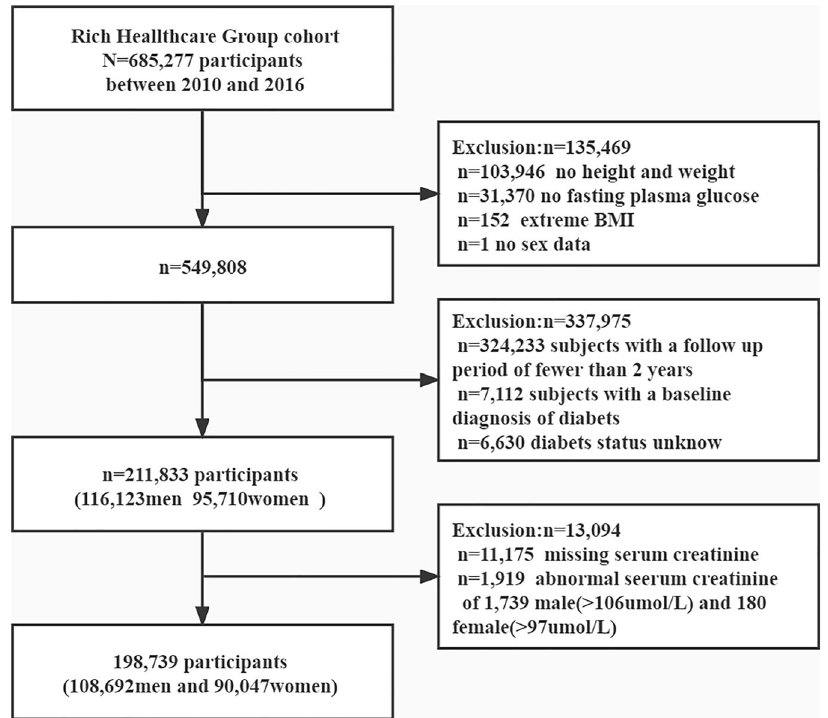
Figure 1. The flow chart of the